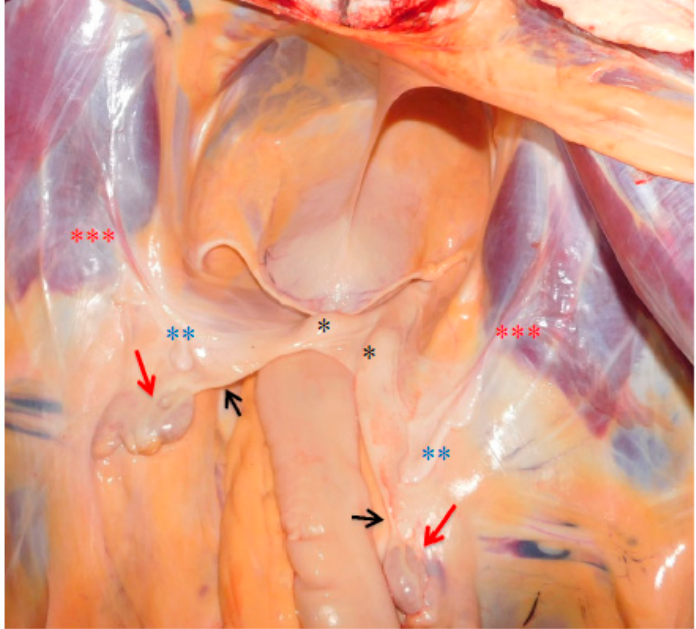
Figure 5. Anatomopathological examination: gonads (red arrows → ) connected to the apex of the uterine horns by a cord-like structure (black arrows → ). Hypoplastic horns and corpus of the uterus (black asterisk *). Two bilateral sacciform structures (blue asterisks **), located between the gonads and the uterine horns, on the lateral band of the wide ligament in caudoventral direction (red asterisks ***), up to the internal inguinal ring (a typical characteristic of the cremaster muscle).